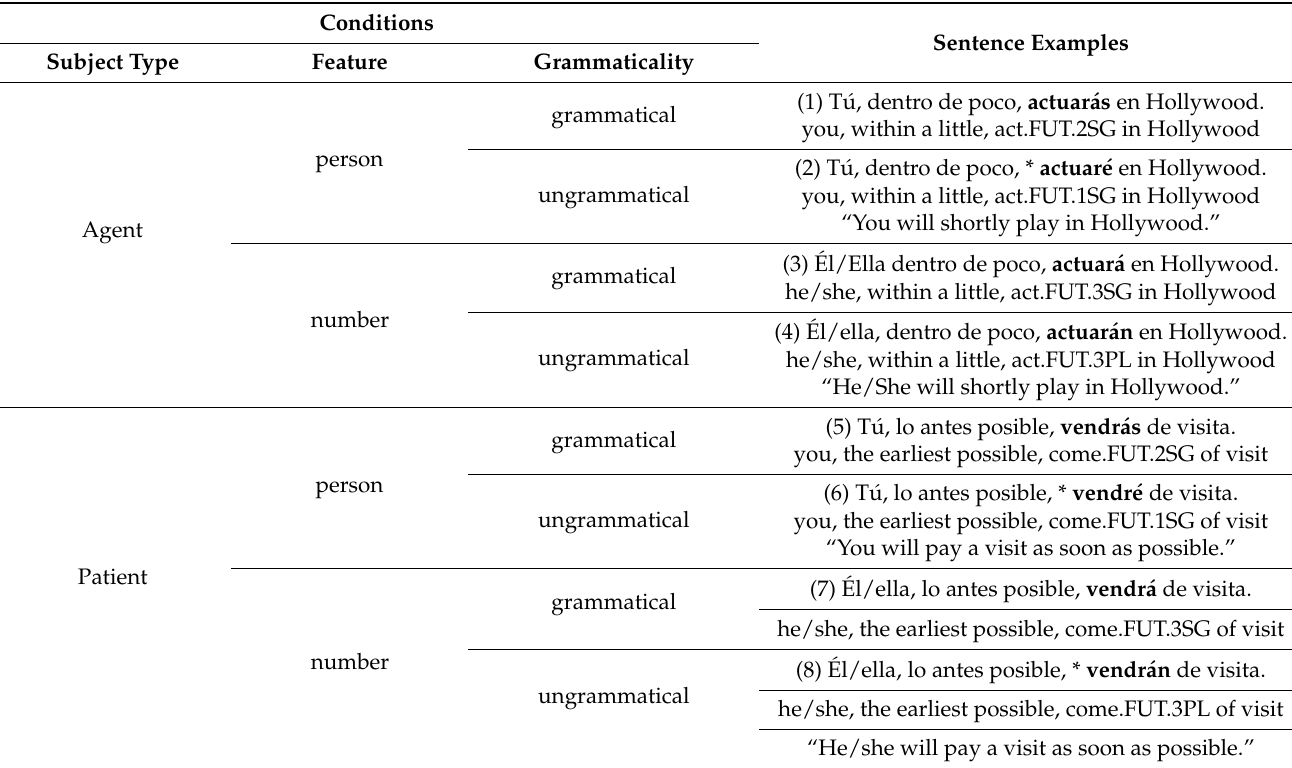
Table 2. Sample of the materials used in the